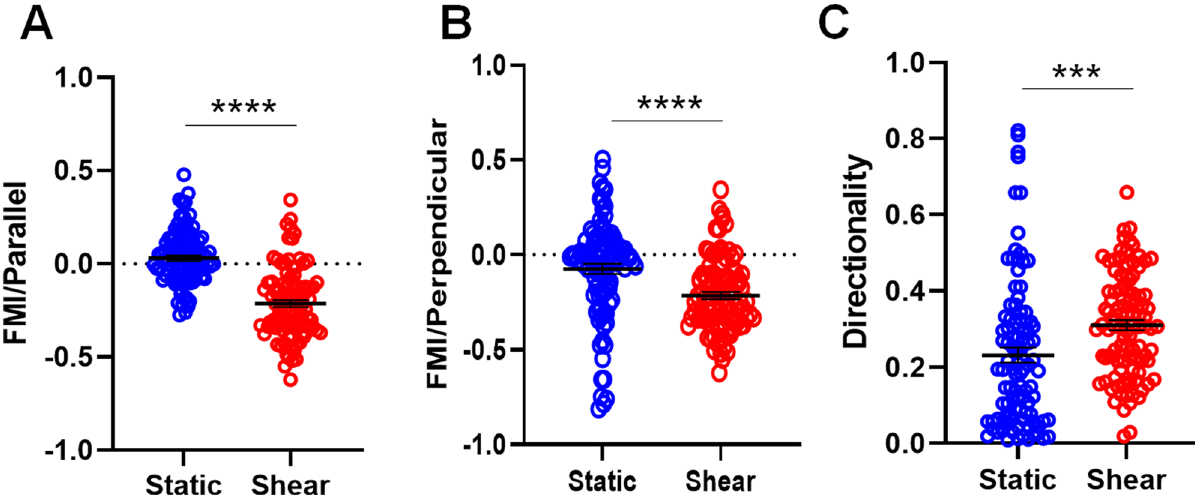
Figure 4. Shear stress affects the migratory patterns of DCs. Quantitative analysis of migratory behaviors according to ( A ) parallel FMI, ( B ) perpendicular FMI, and ( C ) directness of individual cells by shear stress (Chemotaxis and Migration tool, http:// www. ibidi. com; n = 3 independent experiments; unpaired t -test, ***p ≤ 0.001, ****p ≤